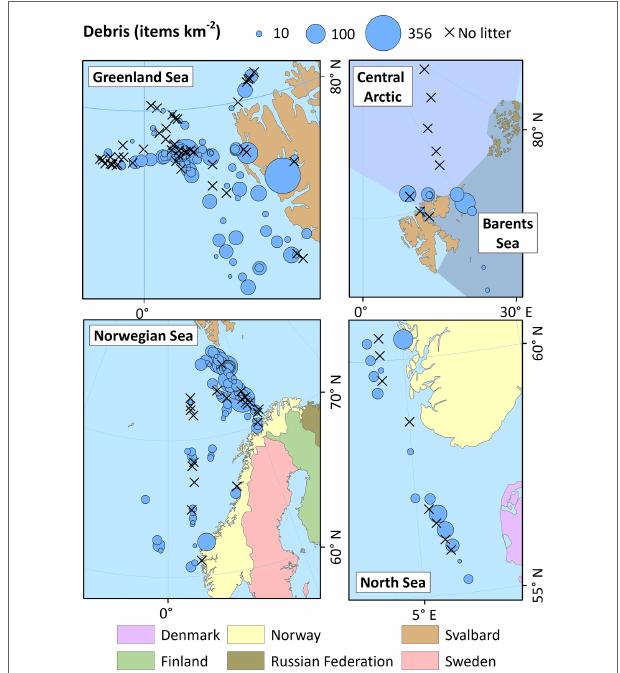
FIGURE 2 | Concentrations of anthropogenic debris (number of items km -2 ) recorded in visual surveys in the Central Arctic, Barents Sea, Greenland Sea, Norwegian Sea and North Sea. The four southern transects in the North Atlantic region are not shown to improve the scaling of the maps. The sizes of the bubbles are proportional to the debris concentrations of the transects. Crosses denote transects with zero